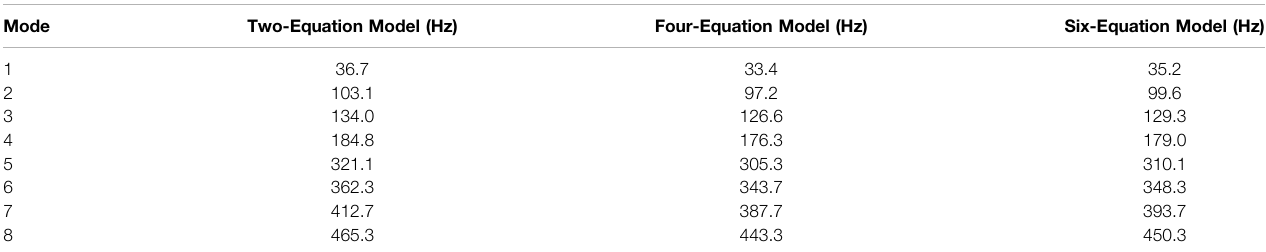
TABLE 1 | First eight modes of pipe with respect to three